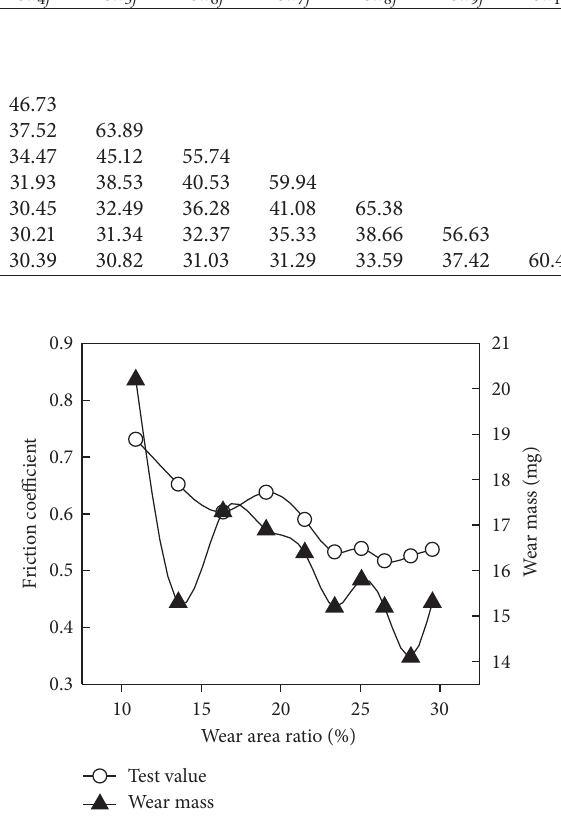
Figure 8: Variation of friction coefficient test value and wear mass with wear area